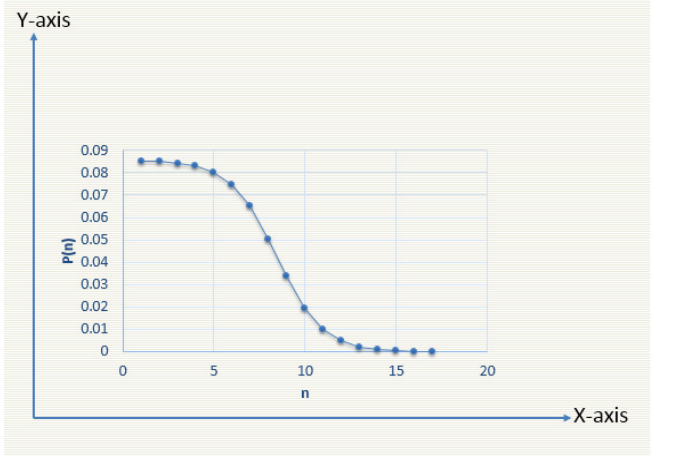
Figure 2. S-shape learning curve.